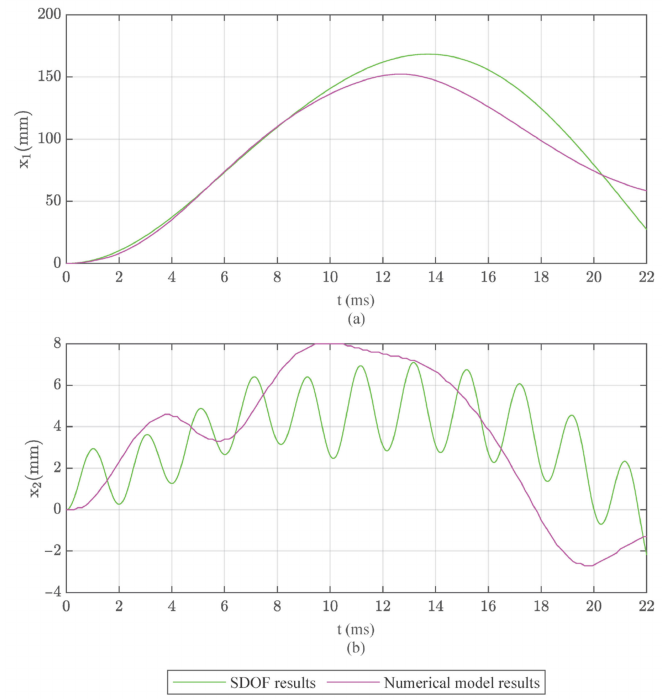
Figure 13. Two-step SDOF analysis and numerical model results of the case study ( a ) cladding and ( b ) columns when subjected to maximum blast pressure of 200 kPa and positive phase duration of 15 ms.